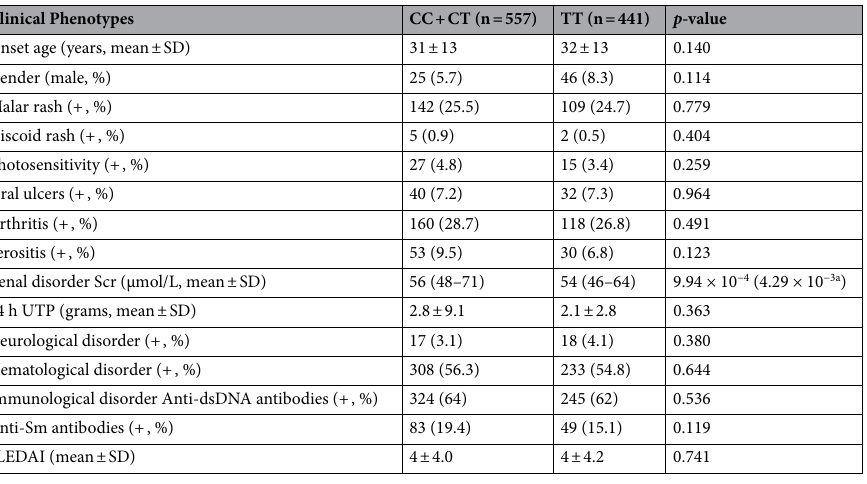
Table 2. Prevalence of SLE clinical phenotypes between ZNF76 rs10947540 polymorphisms in the replication cohort. Scr serum creatinine, 24 h UTP 24-h urinary protein, SLEDAI systemic lupus erythematosus disease activity index. a The p -value of Scr after adjusted for sex and age.